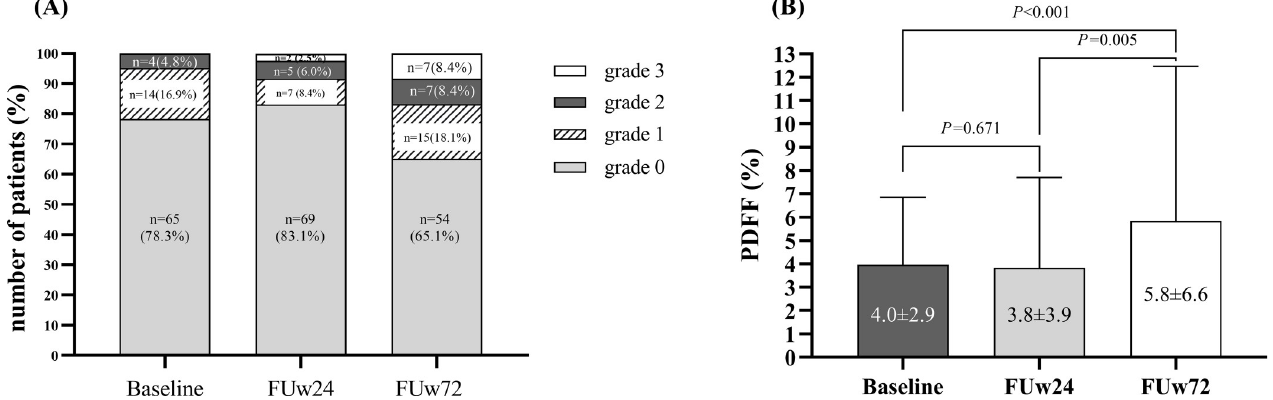
Fig 2. Changes of liver steatosis at baseline, FUw24 and FUw72 (A) Liver steatosis grades (B) Mean liver steatosis.